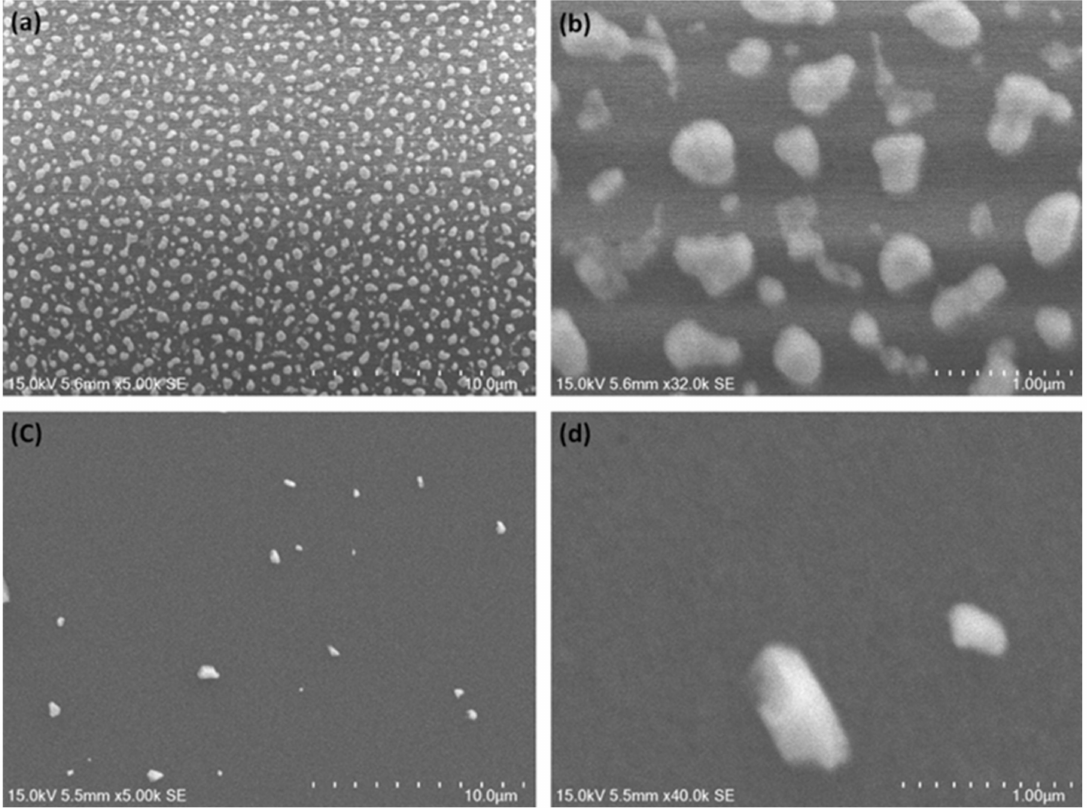
Figure 5. Morphological study of heat-treated pure-Ag and Ag + SiC (5 vol.%) composite layers. SEM images of Ag thin layer were obtained after annealing at 350 ◦ C for 1 h ( a , b ), and Ag + SiC composite thin layer was imaged after exposure to the same temperature (350 ◦ C for 1 h) ( c , d ). Surface imperfections in images ( c , d ) may be due to surface contamination, or slight precipitation.